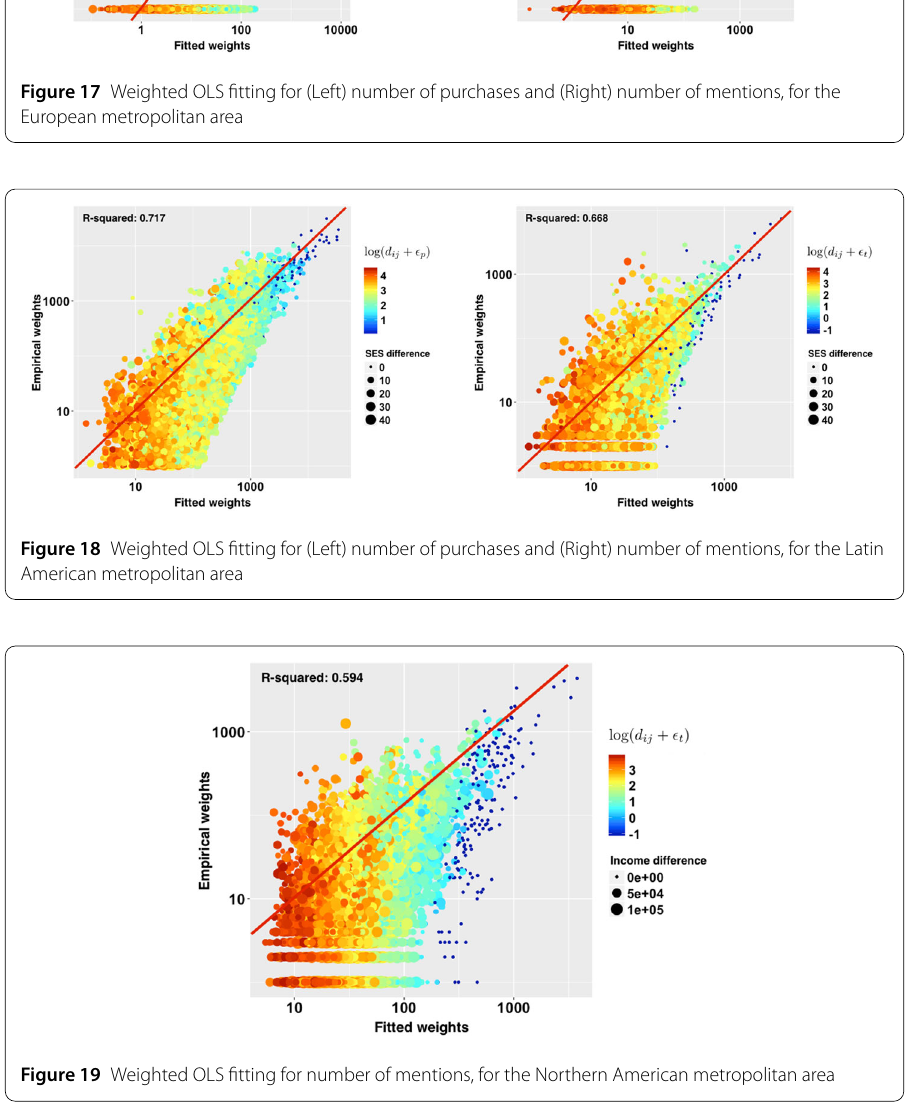
in their home neighborhoods. Specifically, we randomly shuffle the socio-economic sta- tus of the neighborhoods, and construct the artificial interaction networks for both offline purchases and online Twitter mentions. Notice that these artificial interaction networks have the same pairwise edge weights as in the empirical interaction networks, but with node attribute (socio-economic status of the neighborhoods) randomly shuffled. We then scale these artificial interaction networks using the population based weighting